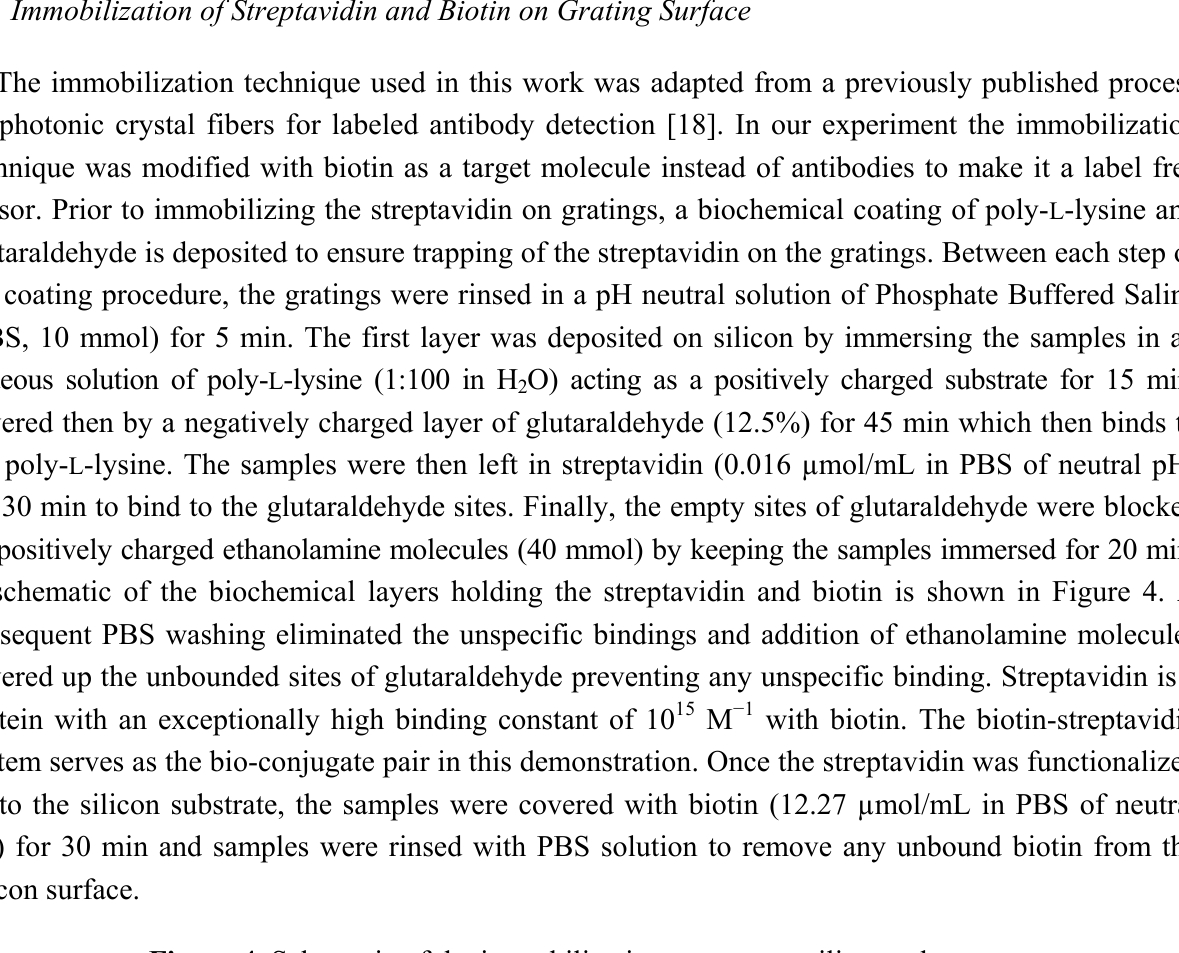
Figure 4. Schematic of the immobilization process on silicon